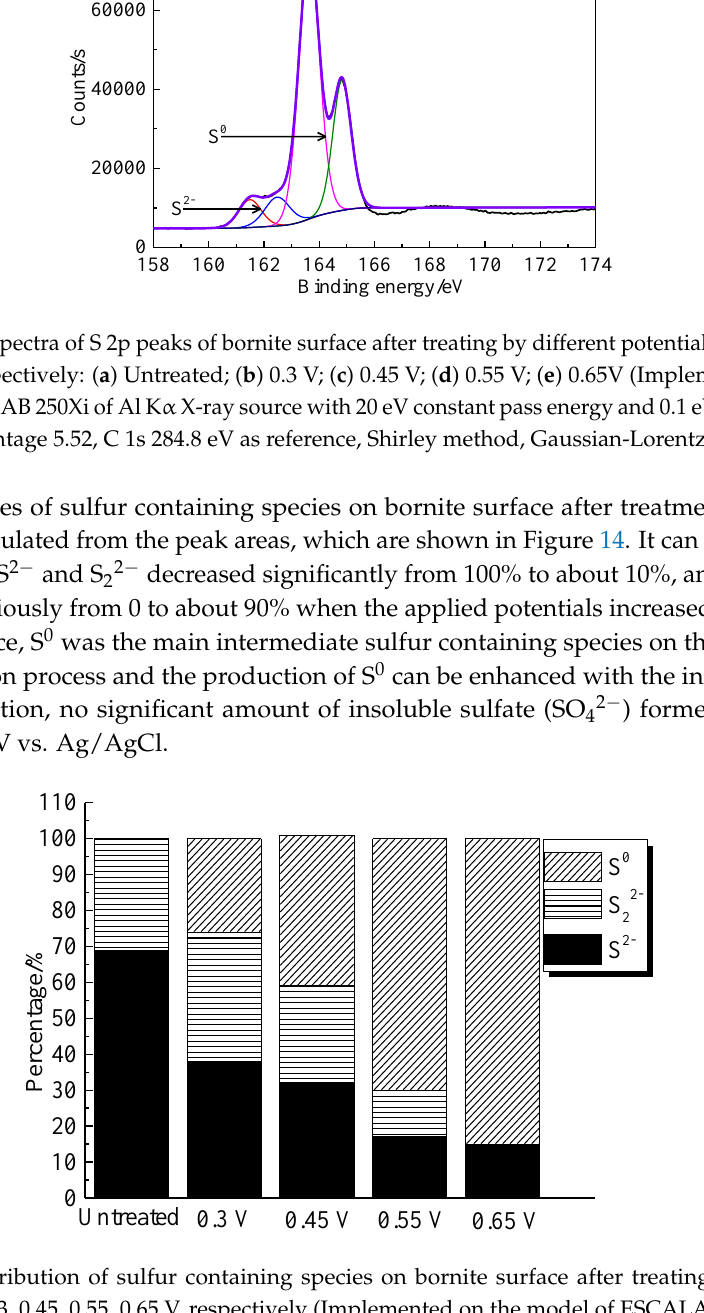
Figure 14. Distribution of sulfur containing species on bornite surface after treating by different potential of 0, 0.3, 0.45, 0.55, 0.65 V, respectively (Implemented on the model of ESCALAB 250Xi of Al Kα X-ray source with 20 eV constant pass energy and 0.1 eV/step; Fitted by Thermo Avantage 5.52, C 1s 284.8 eV as reference, Shirley method, Gaussian-Lorentzian function).